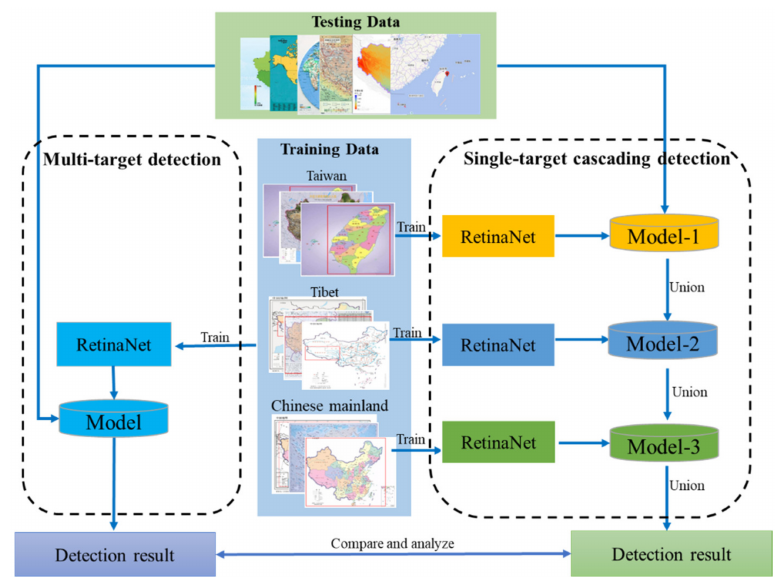
Figure 2. Single-target cascading and multi-target detection model.